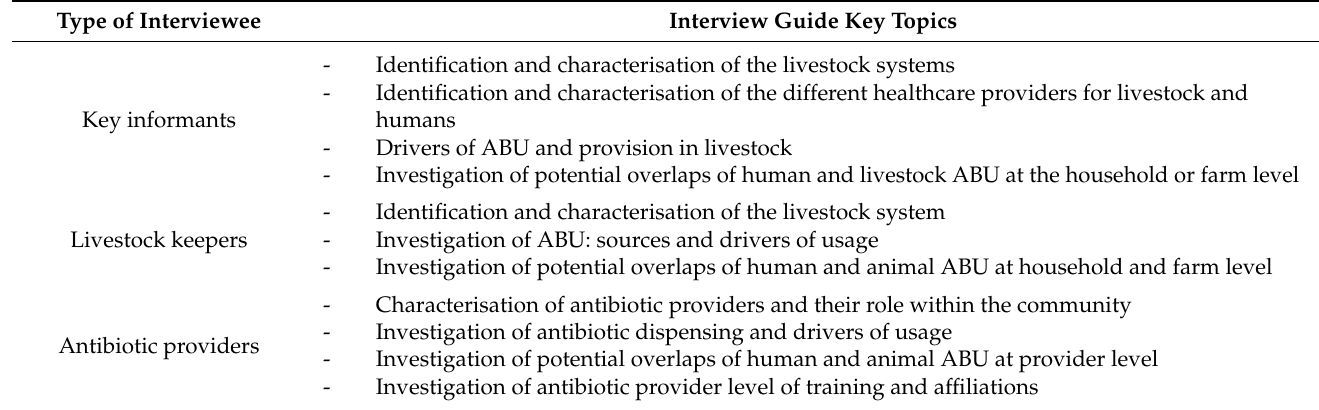
Table 5. Key interview guide topics for the different interview